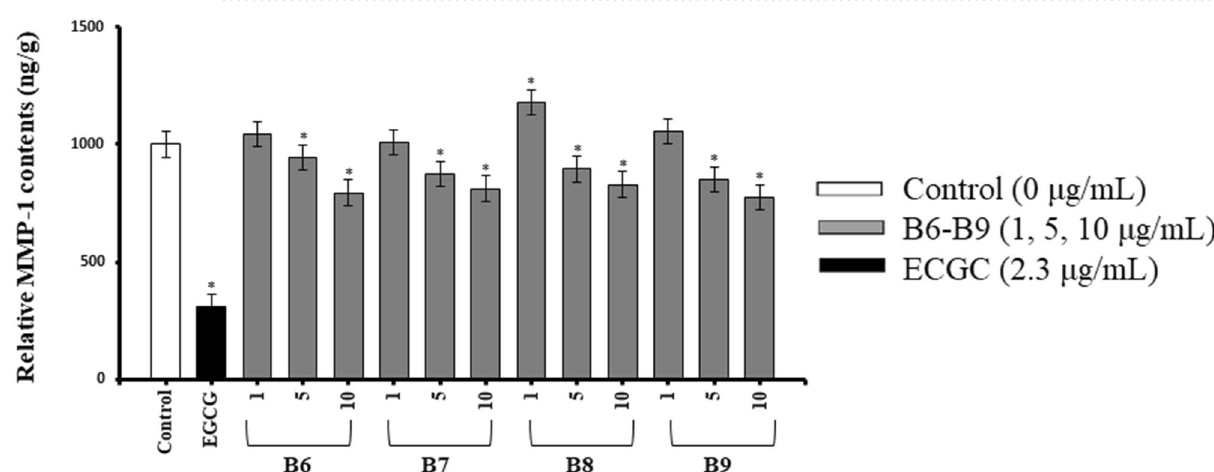
Figure 3. Relative MMP-1 contents 1 in human dermal fibroblasts (HDFs) treated with various concentrations of group B6 to B9. The data are expressed as ng/g when vehicle control is set to 1000 ng/g (Mean ± SD, * p < 0.05, Vehicle control vs. Sample extracts vs. Positive control 2 ). 1 Relative MMP-1 contents: the relative MMP-1 contents in HDFs cells after treatment when the relative MMP-1 content of vehicle control is set to 1000 ng/g. 2 Positive control: epigallocatechin gallate (ECGC). Chart was drawn by Prism Software